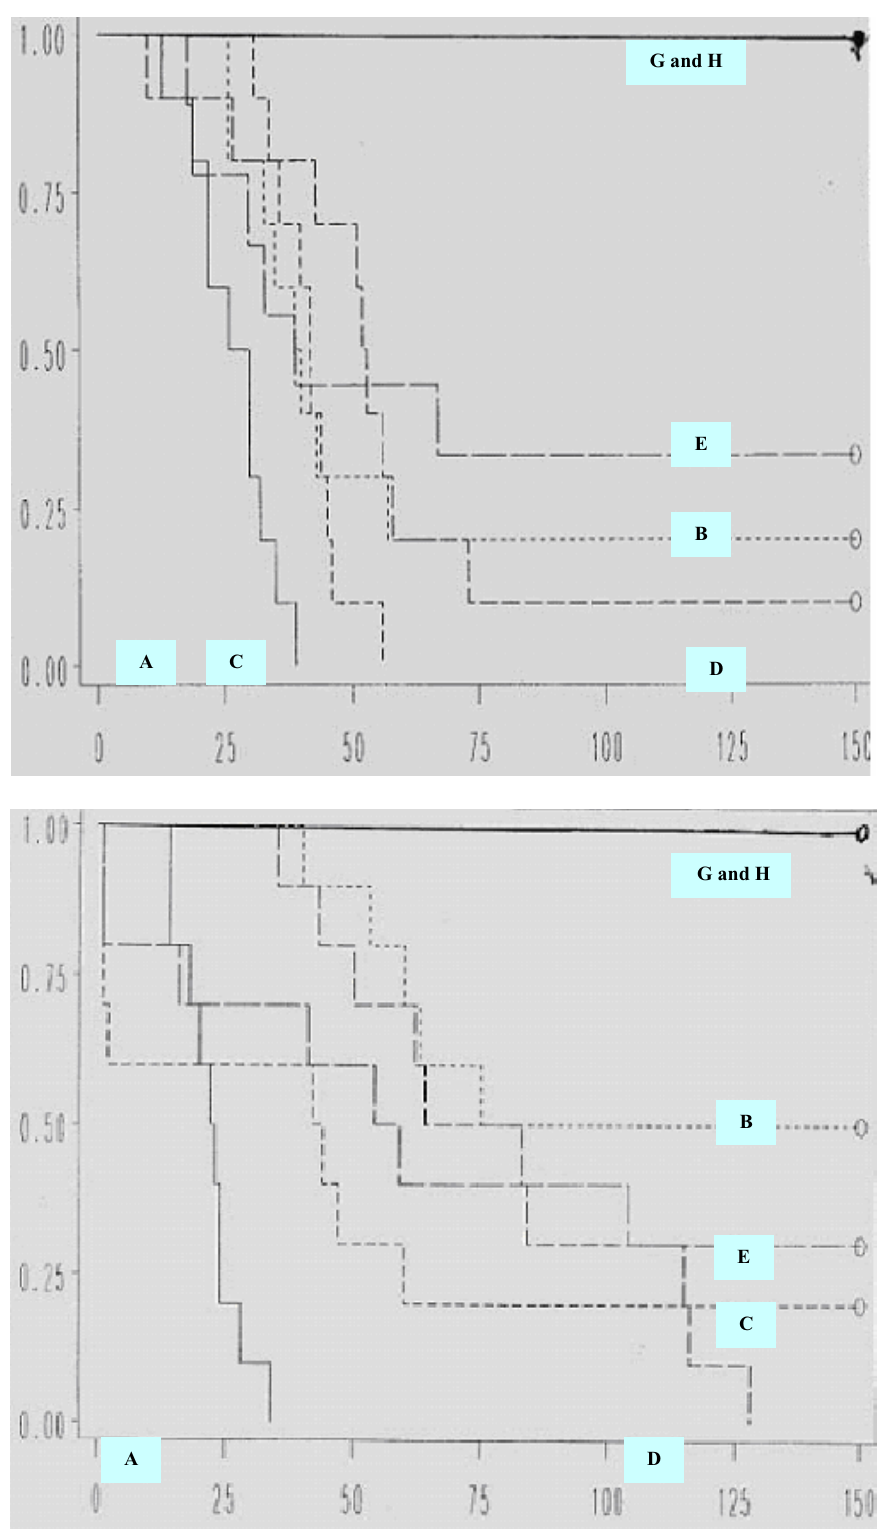
Figure 2. Survival distribution function curves of animals injected with LQQ venom (300 (cid:80) g.kg -1 , s.c.) and lidocaine at a dose of either ( I ) 10 mg.kg -1 or ( II ) 15 mg.kg -1 . The Y-axis represents survival distribution, with (0) indicating death and (1) survival, while the X-axis represents survival time in minutes. ( A ) LQQ venom alone, ( B ) Lid administered 3 min before ( C ) 1 min, ( D ) 5 min, and ( E ) 15 min after LQQ venom. As control, ( G ) Lid and ( H ) 0.9%NaCl were administered